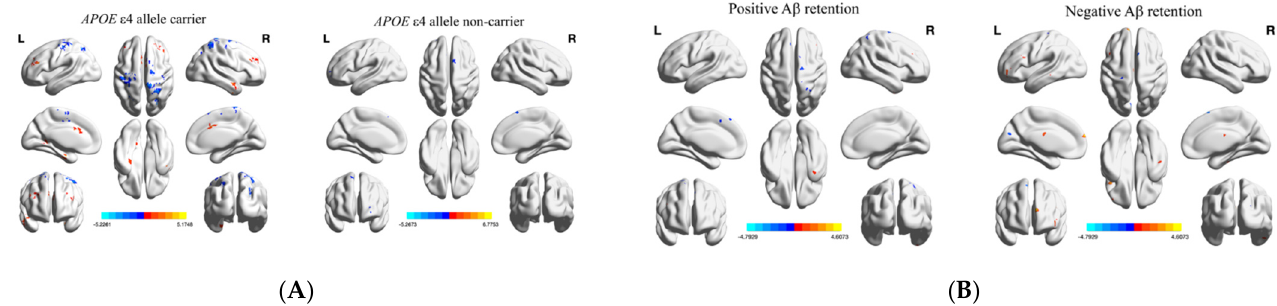
Figure 2. Significant changes in fALFF after tDCS for patients with mild cognitive impairment ( A ) with and without the APOE ε 4 allele, and ( B ) with and without A β deposits. Whole-brain voxel-wise fALFF analysis results. Thresholds were set using GRF correction at a p -value of <0.05, voxel p < 0.001. The statistical threshold of the cluster size is described in Figure 2. Abbreviations: tDCS, transcranial direct current stimulation; DC, degree centrality; A β , amyloid beta.